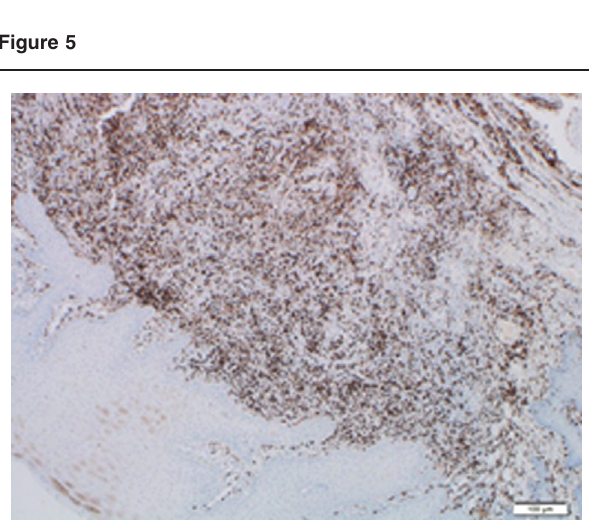
The small vascular spaces are lined plump-appearing endothelial cells (H&E,